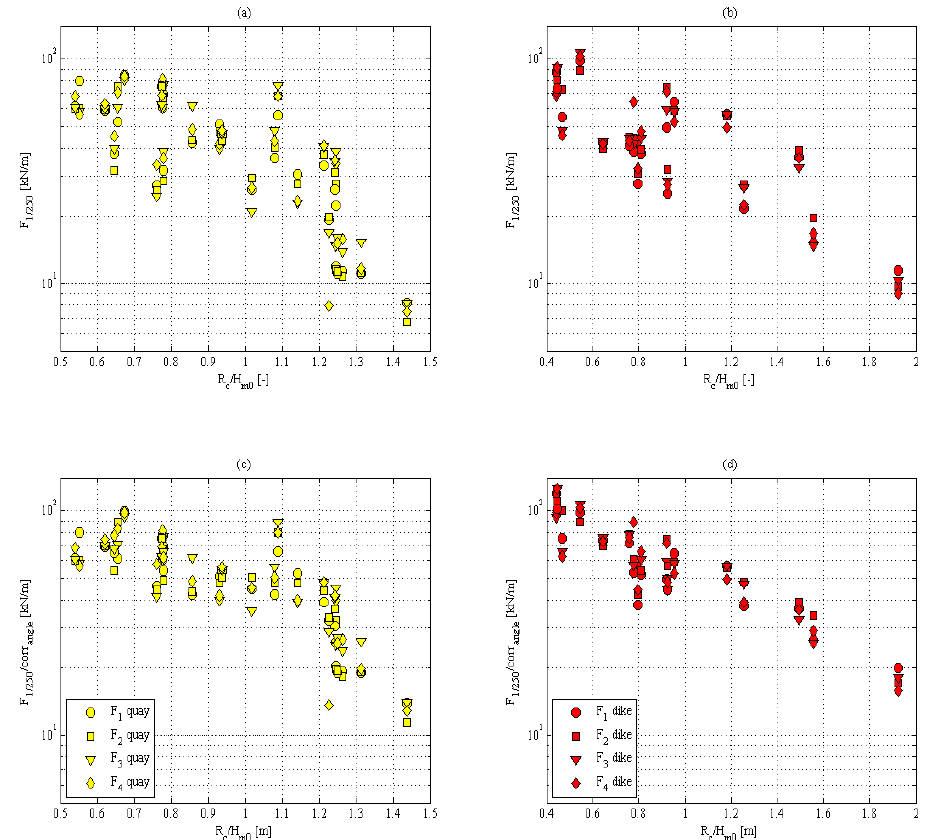
Figure 18. Dependence of the wave force on the relative freeboard with and without reduction factor ( a and c : quay wall; b and d : dike). ( a and c : quay wall; b and d :